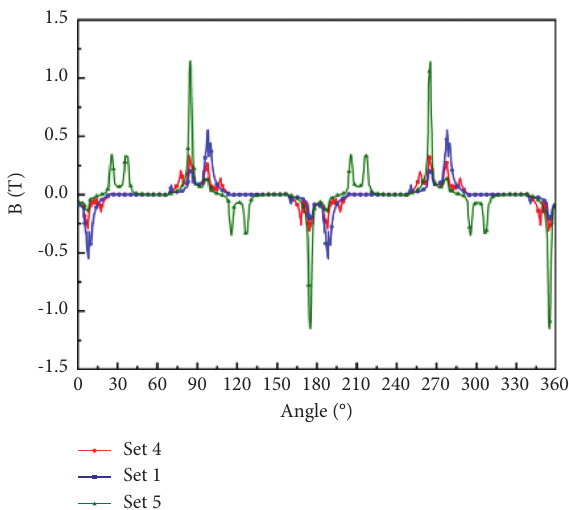
Figure 8: Radial magnetic density versus initial position for the optimal parameter sets.